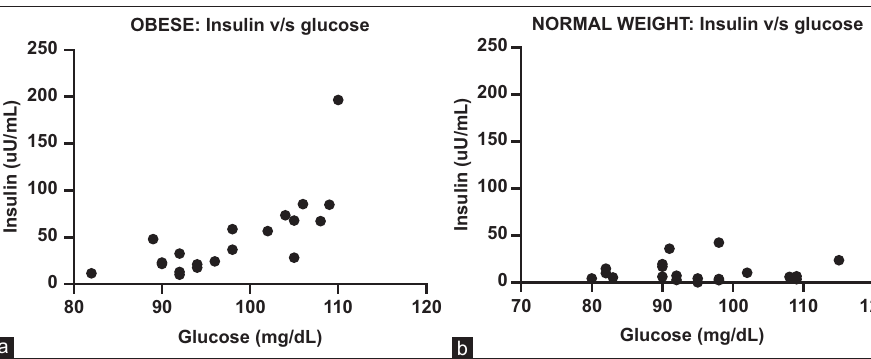
Figure-2: Insulin and glycemia in dogs with obese and normal weight. (a) Obese. As blood glucose increases, increases in insulin levels are observed. Spearman correlation 0.79 (b) normal weight. They do not observe changes in insulin as glucose increases. Spearman correlation